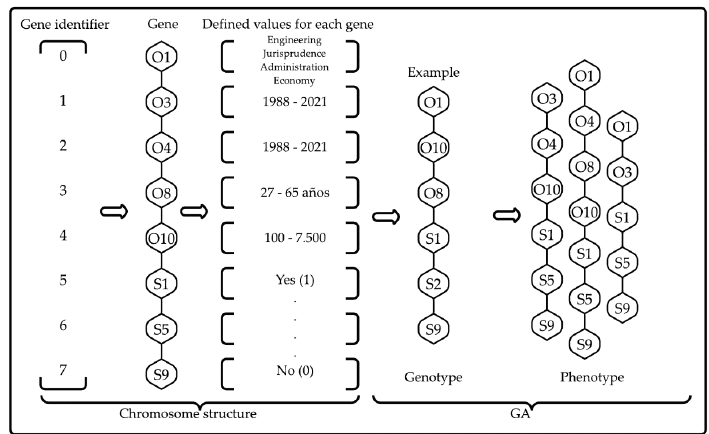
Figure 2. Representation of individuals (chromosome).